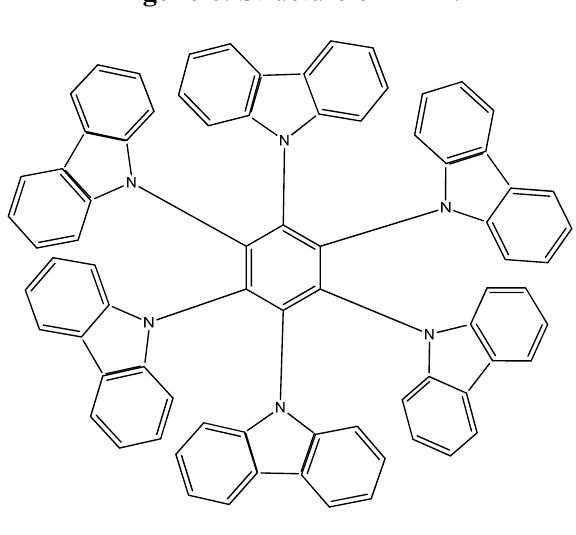
Figure 6. Structure of HAB